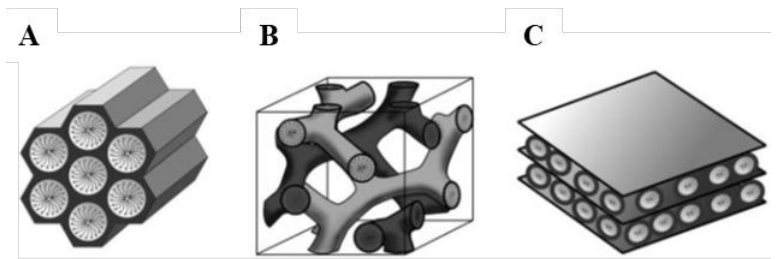
Figure 4. Structures of mesoporous M41S materials: MCM-41 ( A ), MCM-48 ( B ) and MCM-50 ( C ) [22]. Reprinted with permission from [22]. Copyright 2006, John Wiley and Sons. Silica-based hybrids can be achieved by (i) post-synthetic modification of the pore surface of a purely inorganic silica material (grafting), (ii) co-condensation of a silica pre- cursor and a silyl derivative bearing the functional group of interest (“one-pot” approach), (iii) condensation of bisilylated precursors featuring the functional group of interest in the linker between the two alkoxysilyl groups (alone or together with a minimal amount of tetra-alkoxysilyl precursor), leading to a material in which the organic functionalities are imbedded within the pore walls. 2.1. Post-Synthetic Modification (Grafting) Grafting refers to the post-synthesis modification of the surfaces of mesostructured silica phases with organic groups. This process is mainly carried out by reaction of orga- nosilanes of the type RSi(OR’) 3 with the free silanol groups on the pore surfaces. Less fre- quently chlorosilanes ClSiR 3 or silazanes HN(SiR 3 ) 2 are used (Figure 5). In principle, by varying of the organic residue R, functionalization with different or- ganic groups can be achieved. By implementing this approach, the mesostructure of the starting silica phase is usually retained. On the other hand, a reduction in the porosity of the hybrid, compared to the parent mesoporous silica, is usually observed, proportionally to the size of the grafted organic moieties. Furthermore, the organic silyl-derivatives might preferentially react with the surface silanol groups that they will encounter first, i.e., those located at the pore mouth or at the initial part of the mesoporous channels. This effect is modulated by several factor. Firstly, the reactivity of the alkoxy groups bounded to the silicon atom determines the ease with which hydrolysis/condensation reactions can occur.